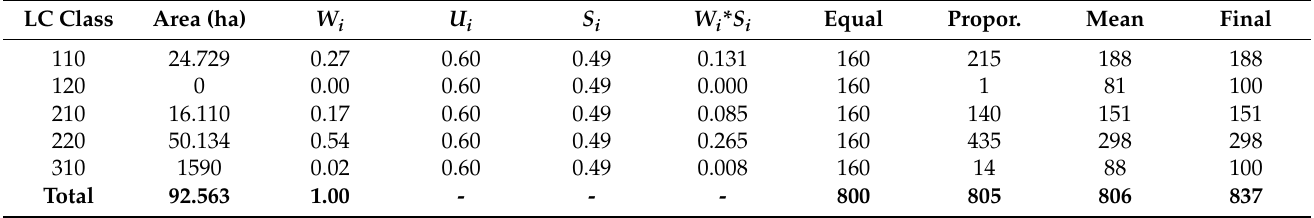
Table A4. Calculation of the sample size of the land cover map of the municipality of Rome from multi-temporal data classification after the application of the “erosion”